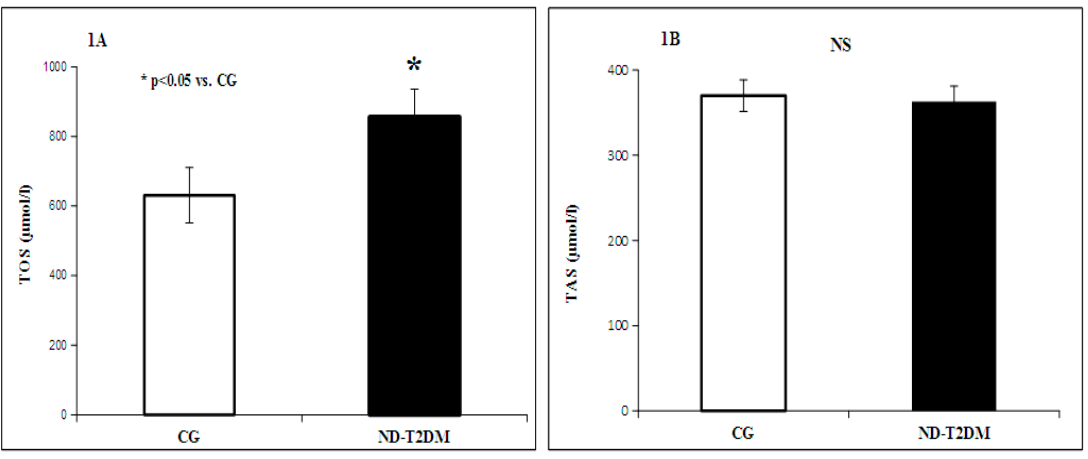
Figure 1. Total oxidant status (TOS) ( A ) total antioxidant status (TAS) ( B ) in patients with ND-T2DM versus control group (CG).